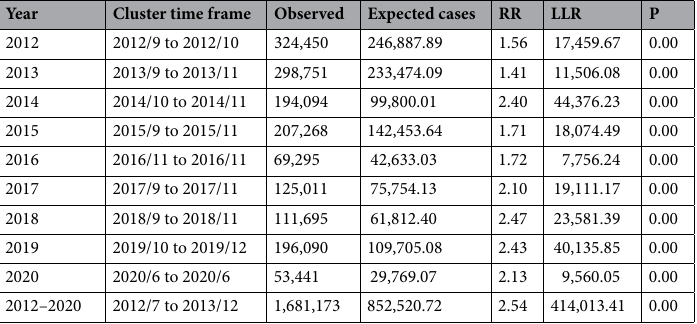
Table 2. Temporal clustering of malaria incidence in the Amhara regional state, Ethiopia, 2012–2020. LLR log-likelihood ratio, RR relative risk, P p-value.